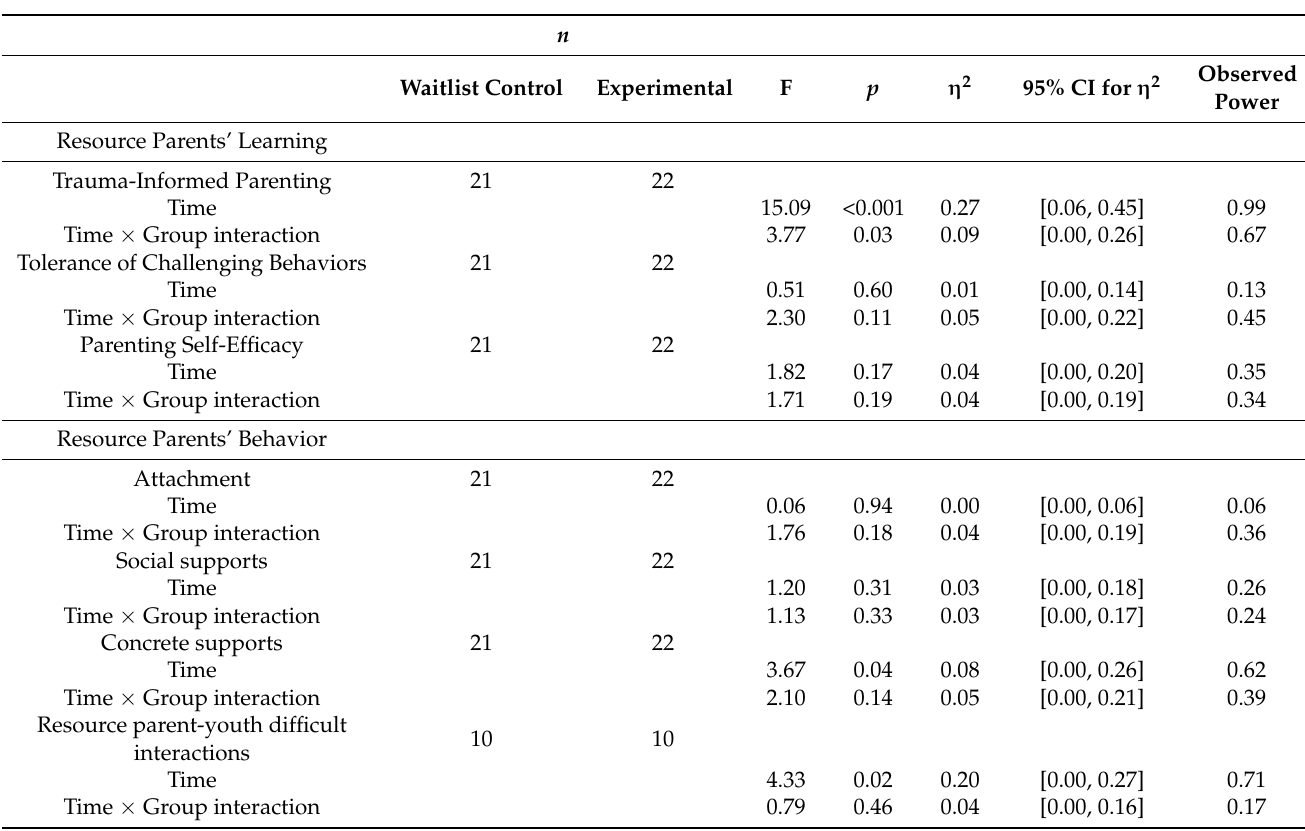
Table 2. Results for the RPC’s Impact on Preliminary Outcomes of Resource Parents’ Learning and